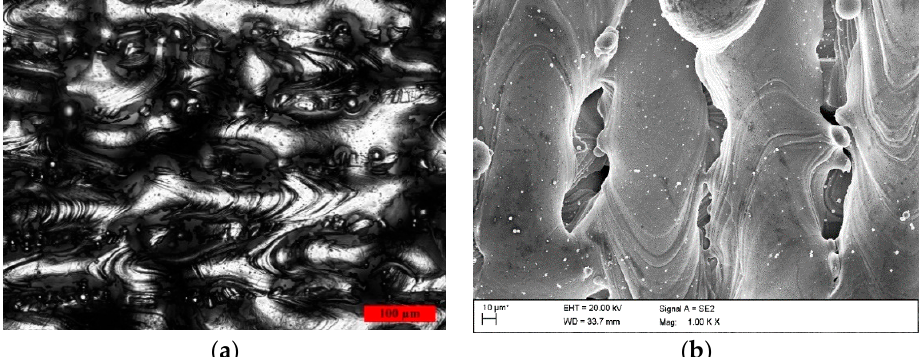
Figure 18. The surface structure of Ti6Al4V Ti solid 1 alloy specimen made ( a ) on a light microscope and ( b ) on an SEM.